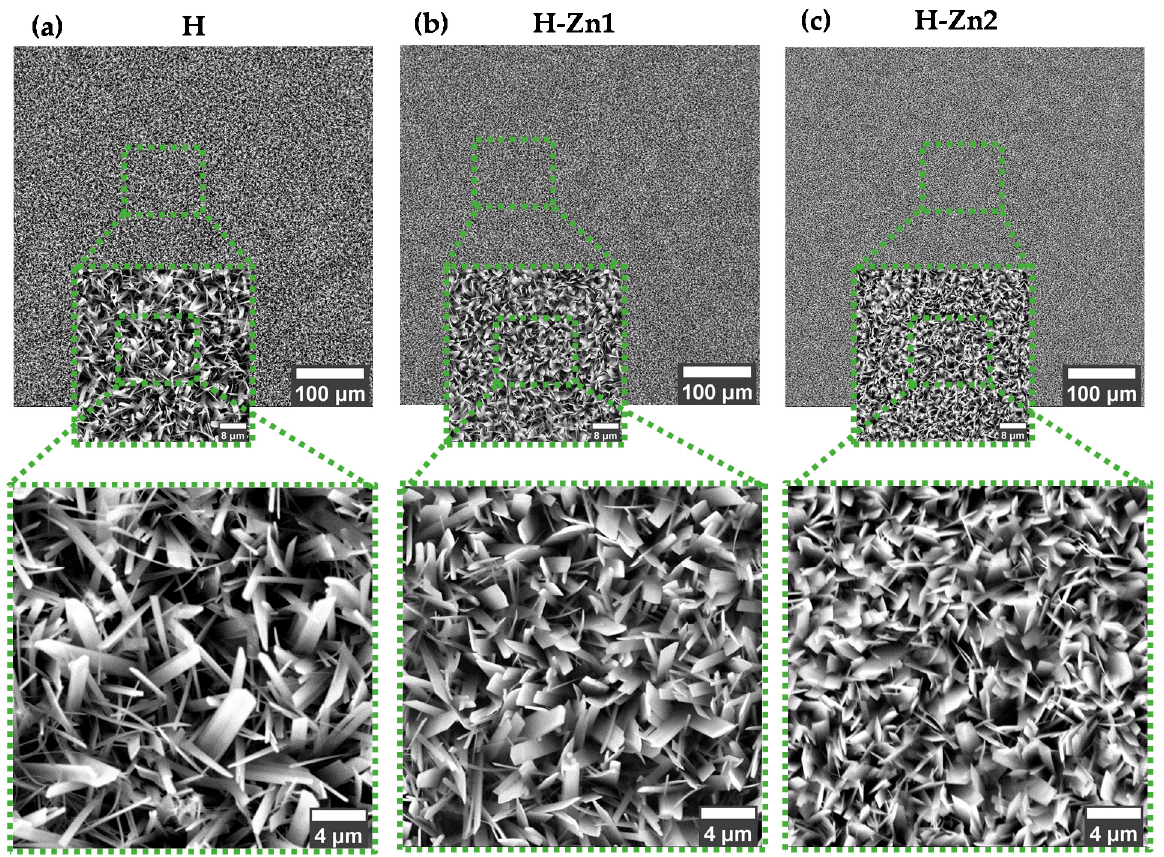
Figure 2. Morphology of the undoped (( a ) H) and zinc doped hydroxyapatite (( b ) H-Zn1 and ( c ) H- Zn2)